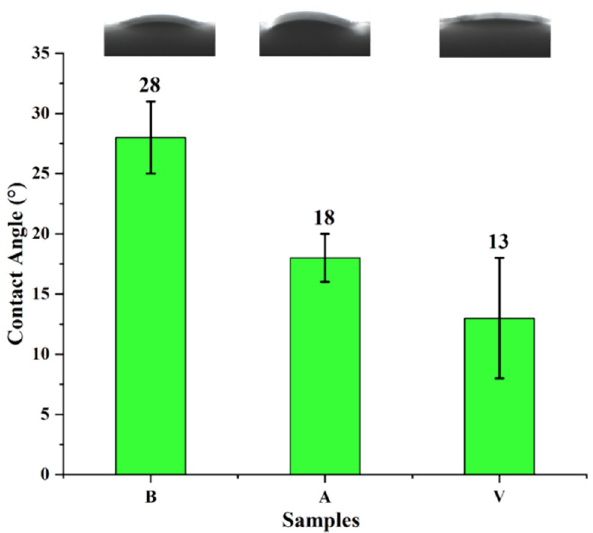
Figure 13. Contact angle of a stone sample surface. B is a blank stone sample, A is an aragonite- treated sample, and V is a vaterite-treated